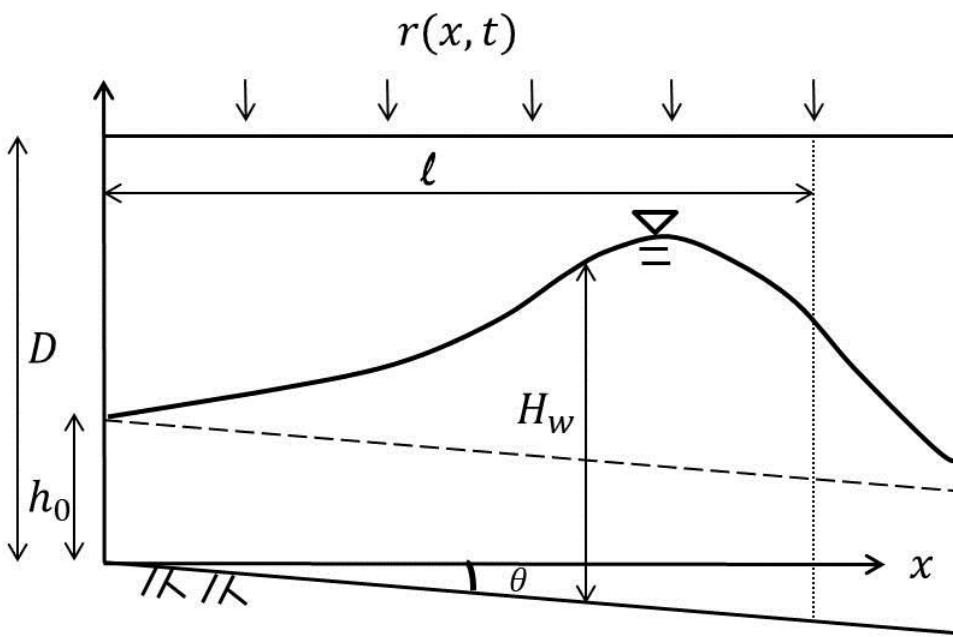
Figure 1. Schematic diagram of a sloping aquifer; the simulation range is semi-infinite and there is a surface recharge from x = 0 to x = ℓ .